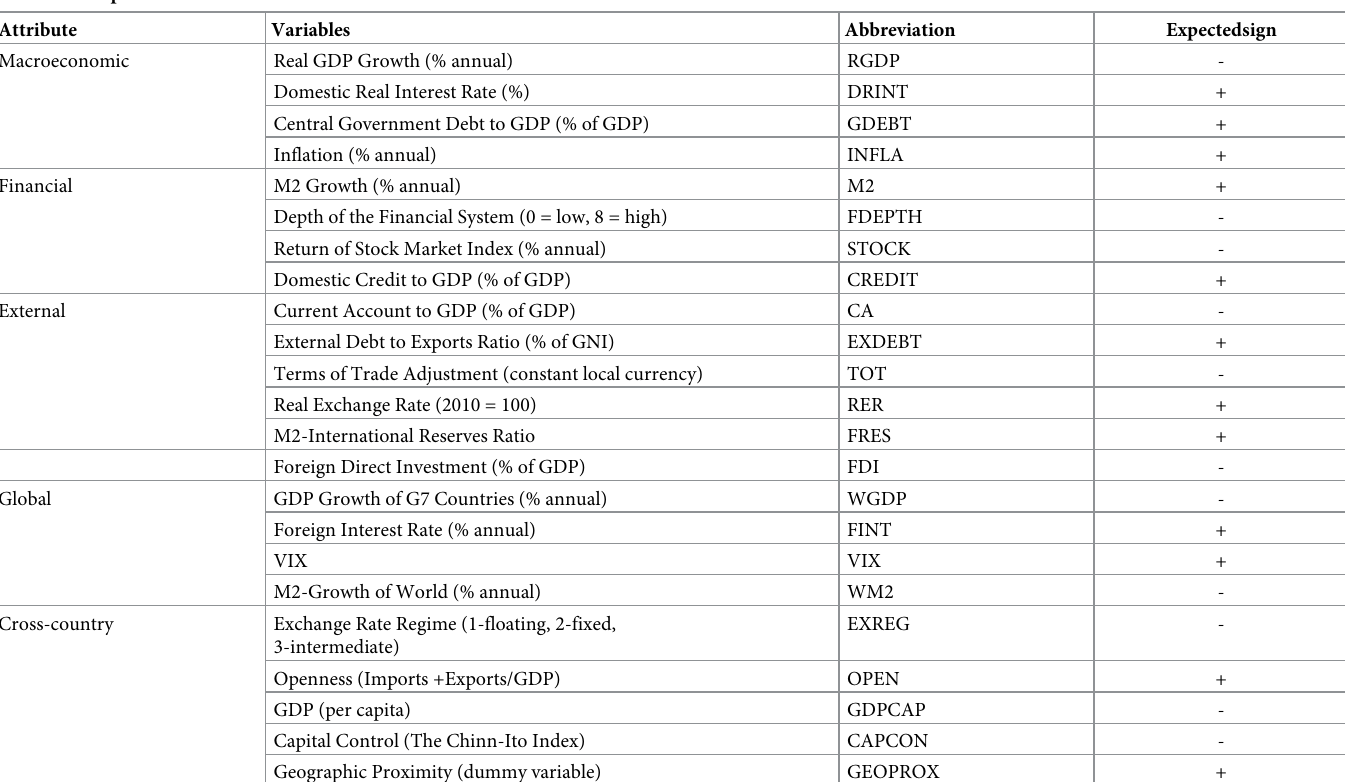
Table 1. Independent variables.